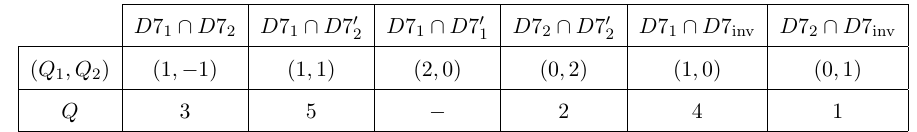
Table 7 . U(1) charges for the charge 5 (II) model. The state at D 7 1 \ D 7 0